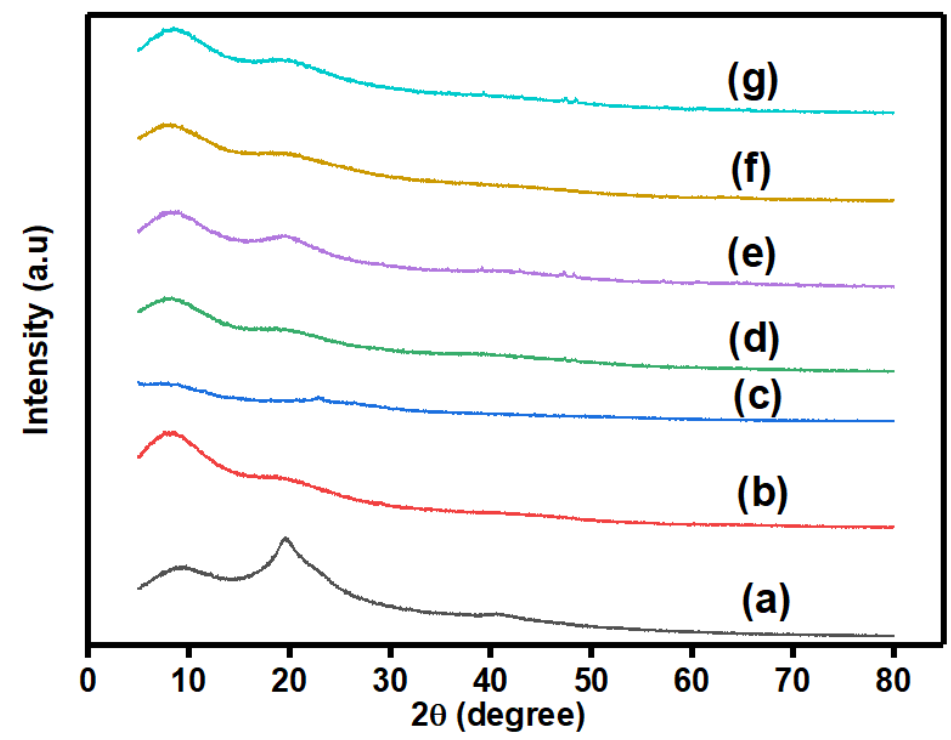
Figure 5. XRD diffractograms of ( a ) PVA, ( b ) (PVA/Agar)/H 2 SO 4 hydrogel electrolyte, ( c ) PANI/PPy, ( d ) PAP1, ( e ) PAP2, ( f ) PAP3, and ( g ) PAP4.